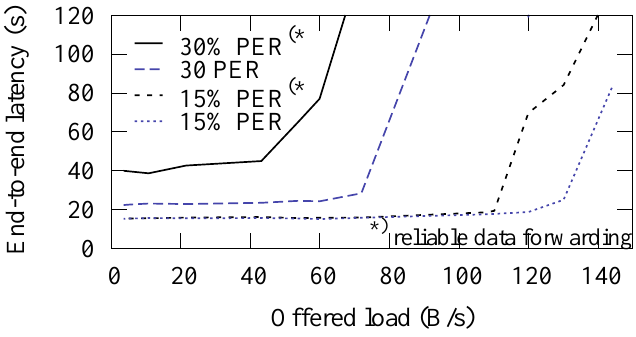
Figure 27. Average end-to-end latency with different packet error rates in ZigBee with and without the reliable data forwarding